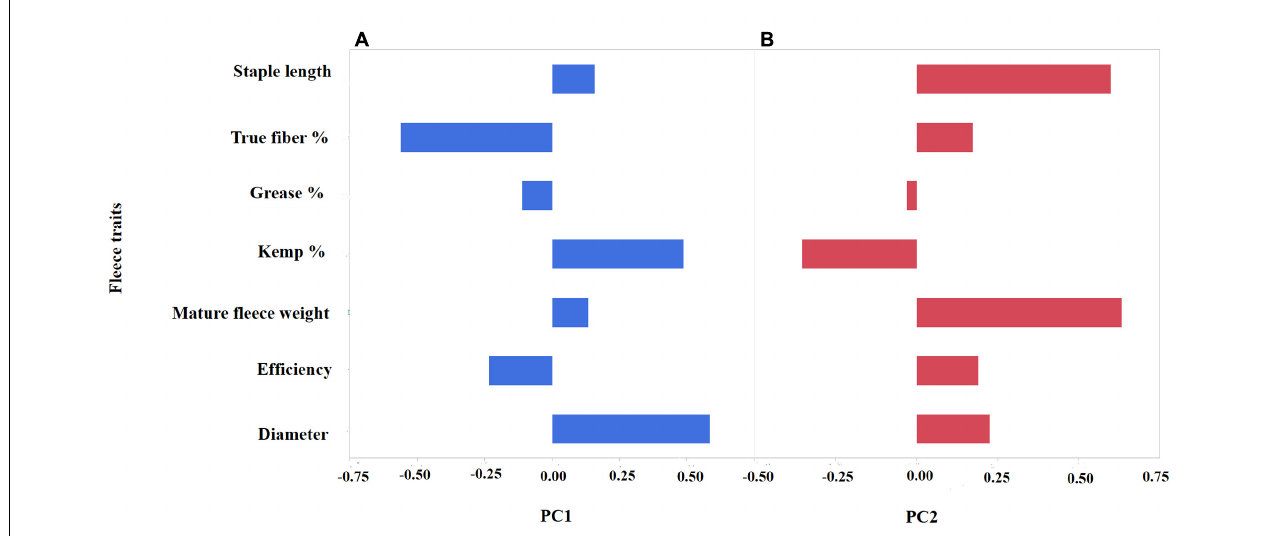
FIGURE 2 | Principal Component Analysis (PCA) depicting the loading values ( x -axis) of seven mohair traits ( y -axis) for PC1 (A) and PC2 (B) . PC1 (blue) broadly describes “mohair quality” as indicated by the positive correlation between diameter and kemp percentage, while having negative correlation to true fiber percentage. PC2 (red) reflects fleece volume with a positive correlation between increased staple length and fleece